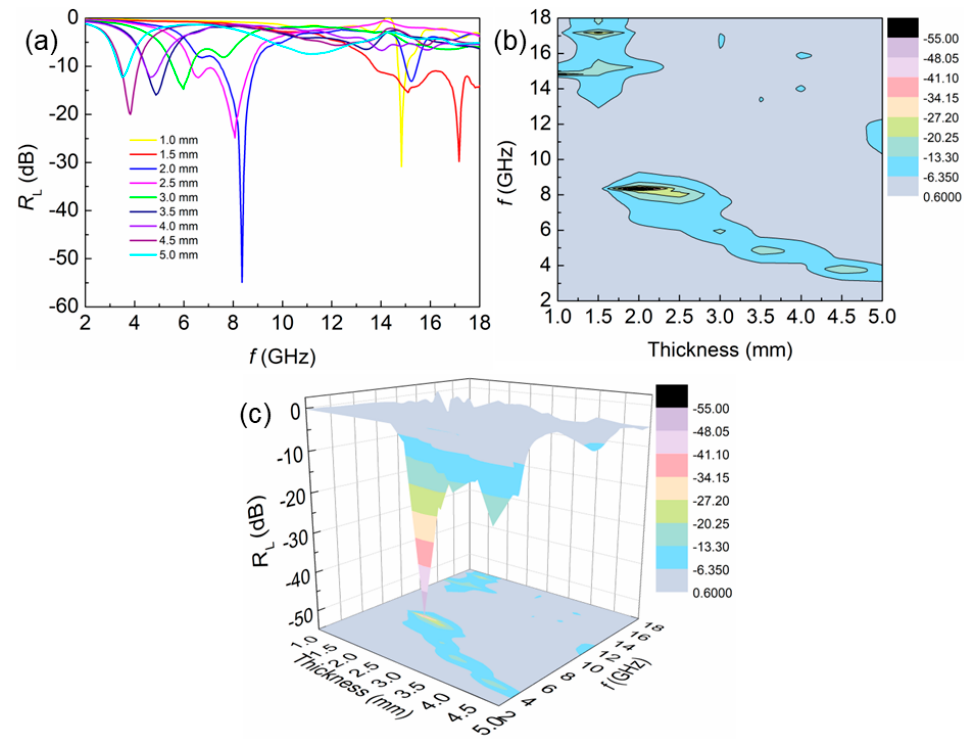
Figure 4. Frequency dependence of reflection loss and sample thickness of as-prepared FeSiBNi2 metallic microwires with a mass ratio of 40 wt.% with different thicknesses of composite at 2–18 GHz: ( a ) frequency dependence of R L curves; ( b ) 2D contour plots of thickness and reflection loss; ( c ) 3D variation diagram of reflection loss after fitting.